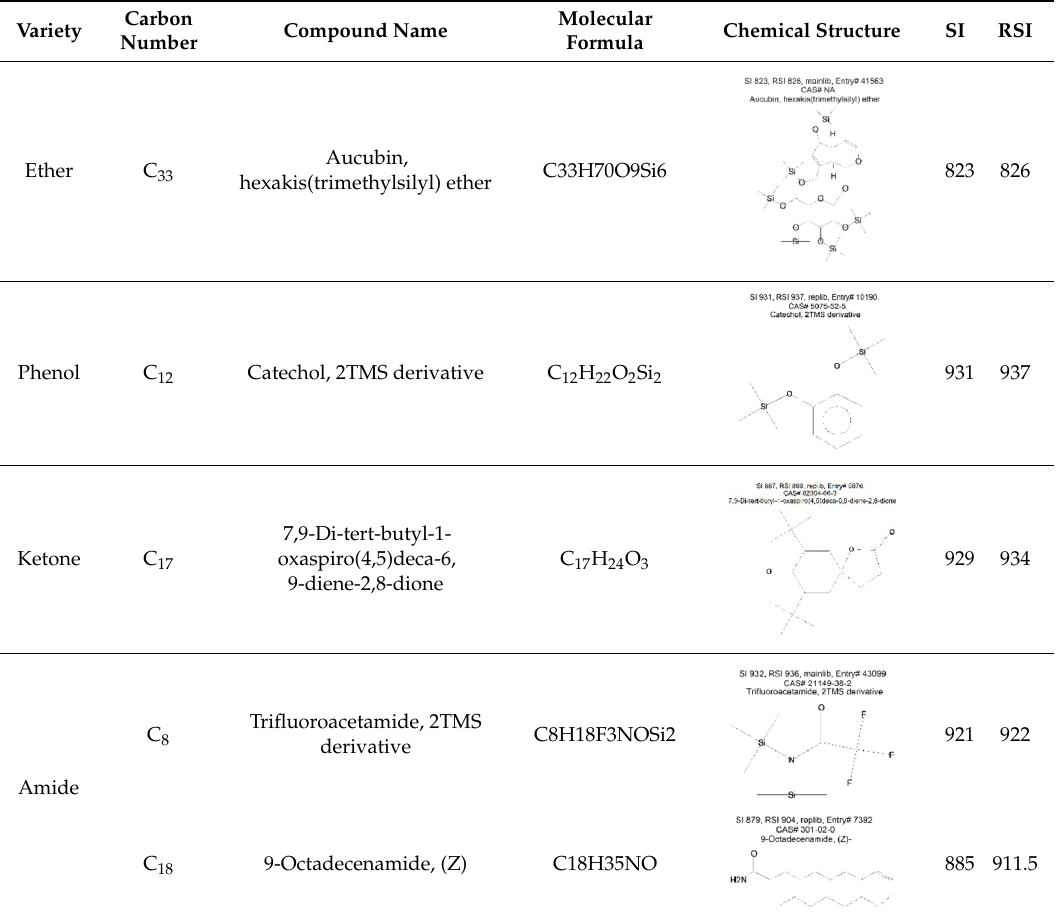
Table 3. The candidate cuticular compounds most positively associated with rust resistance.